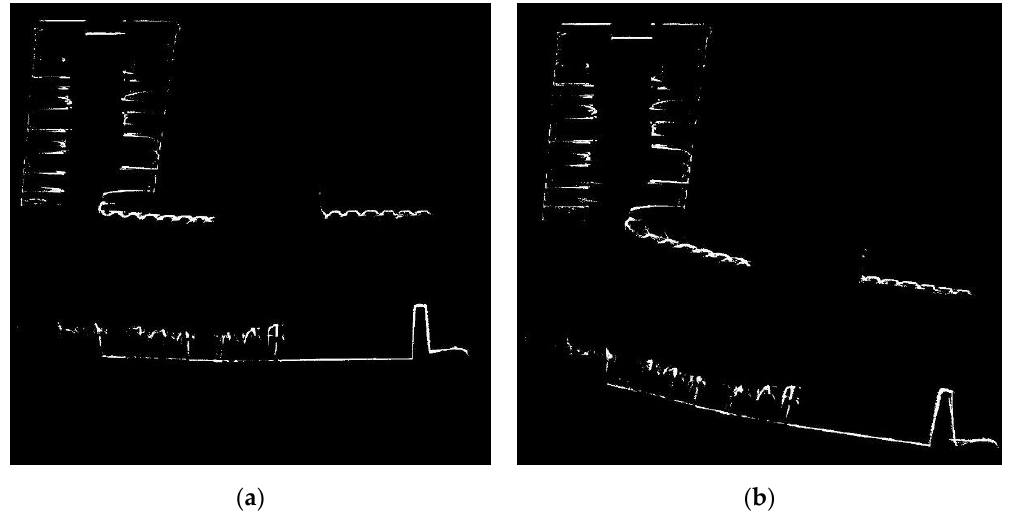
Figure 16. ( a ) Grid map computed by ICP with proposed directional weighting—HD_ICP; ( b ) grid map computed standard